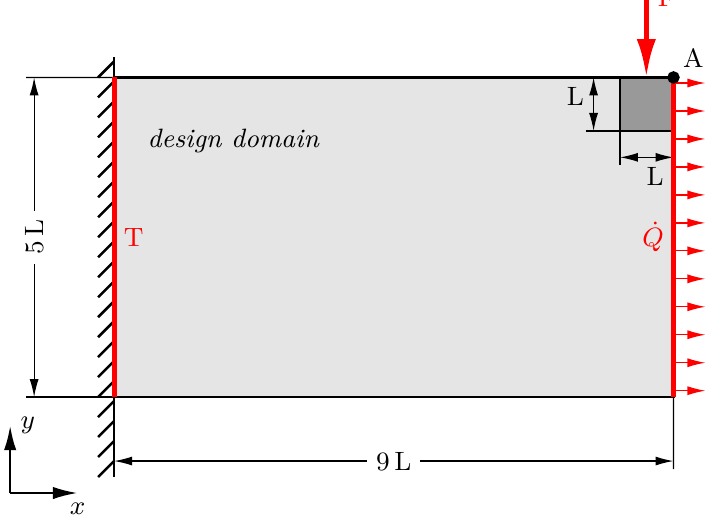
Figure 7. Thermal ( T , ˙ Q ) and mechanical ( F ) loading conditions on a short cantilever beam. Fixed region is shaded. Evaluation point for displacement and temperature is